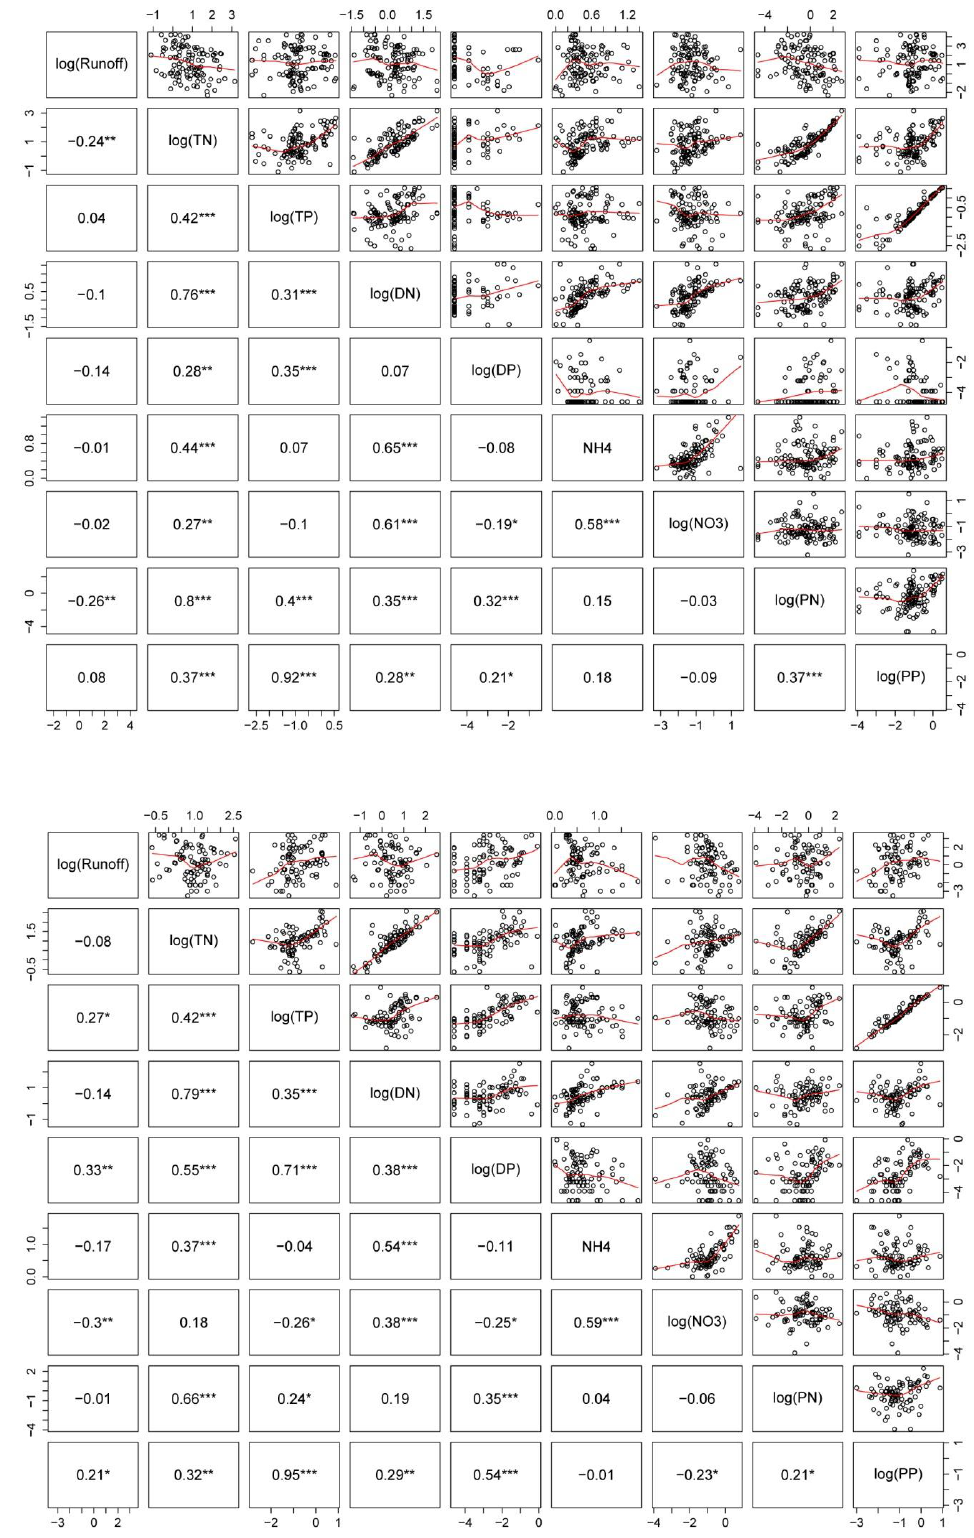
Figure 4. Relationship between the surface runoff and nitrogen and phosphorus concentrations in the tea (the upper) and forest (the lower) systems. *, ** and *** indicate significant relationship at the p < 0.05, 0.01 and 0.001 levels,